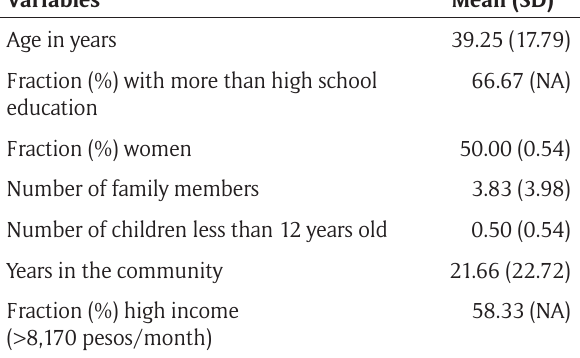
Table 1: Demographic variables of citizen scientists (number of observations =